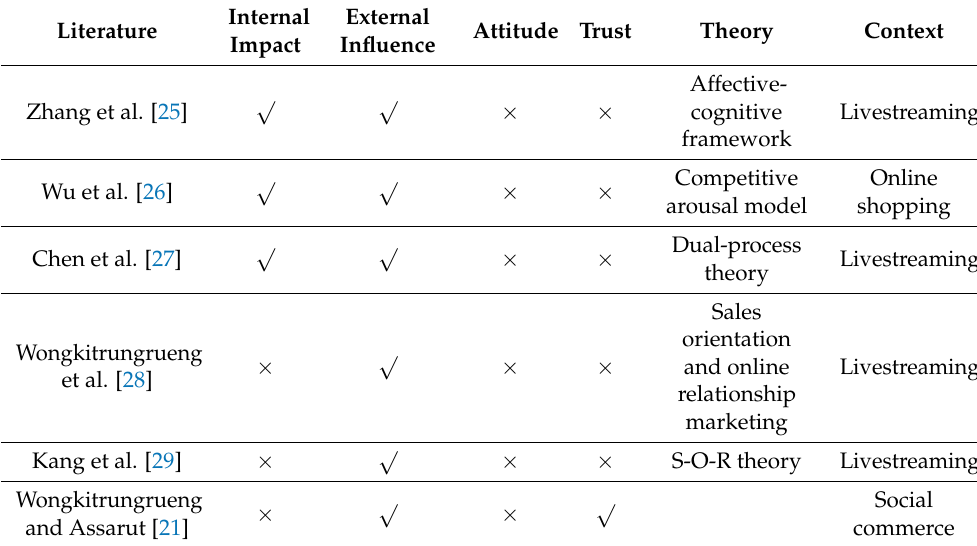
Table 1. Literature review and summary related to livestreaming